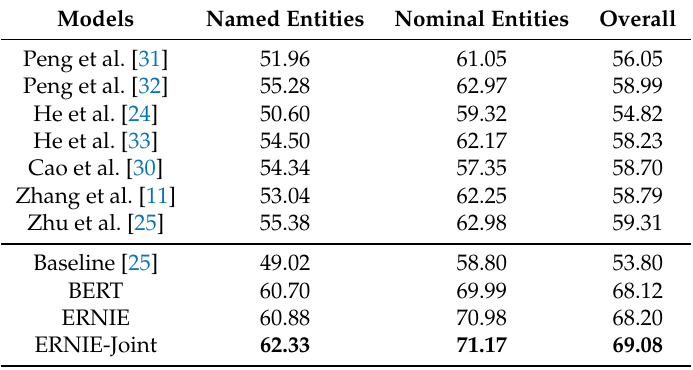
Table 6. The results on the